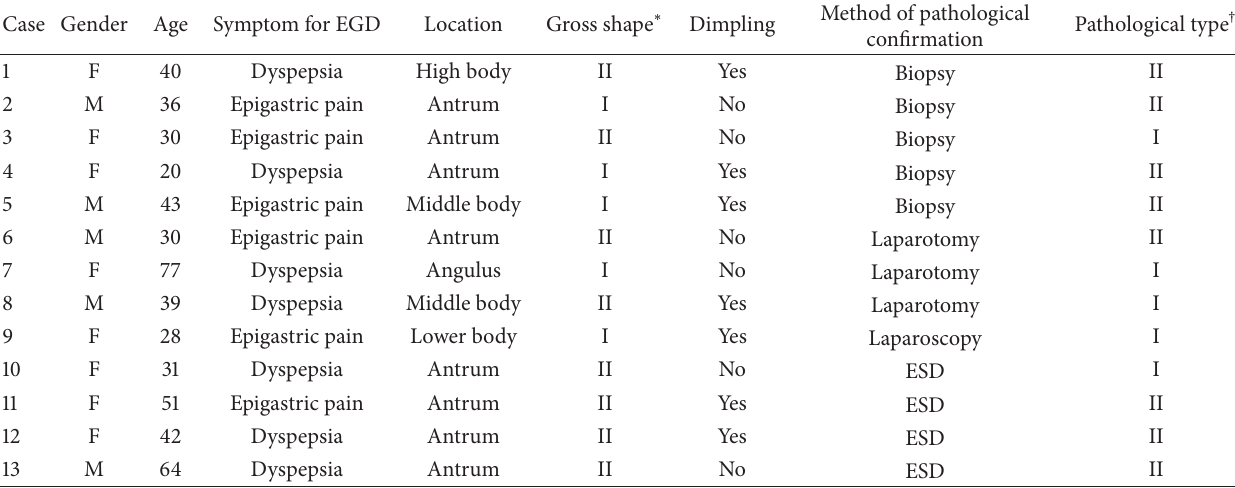
Table 1: Clinicopathological characteristics in 13 patients with gastric ectopic